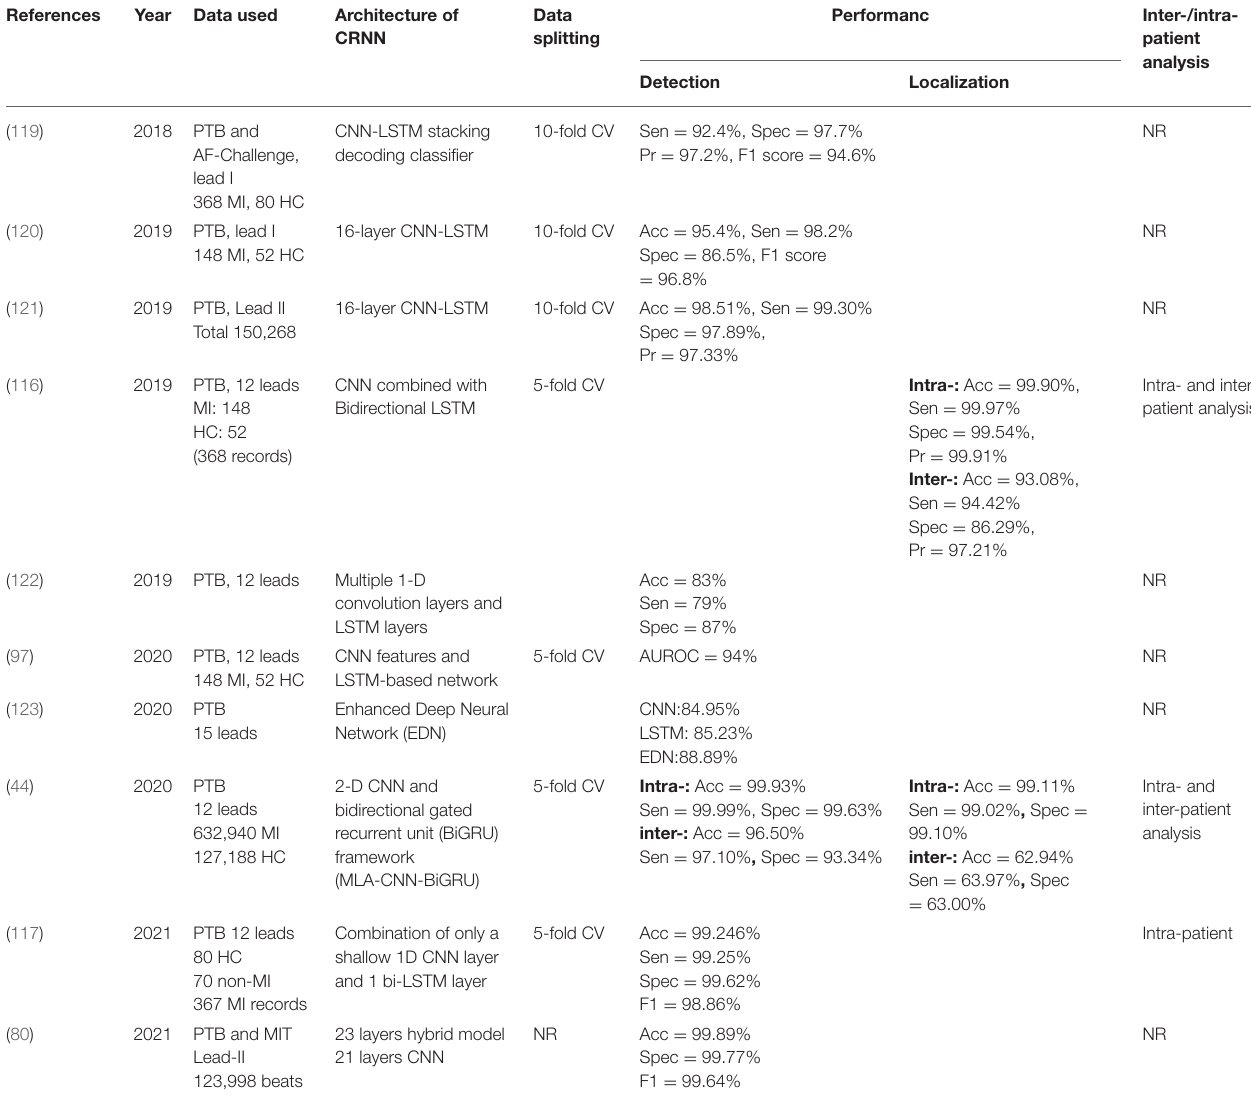
TABLE 6 | Properties of some notable convolutional recurrent neural network (CRNN)-based ECG MI detection and localization.